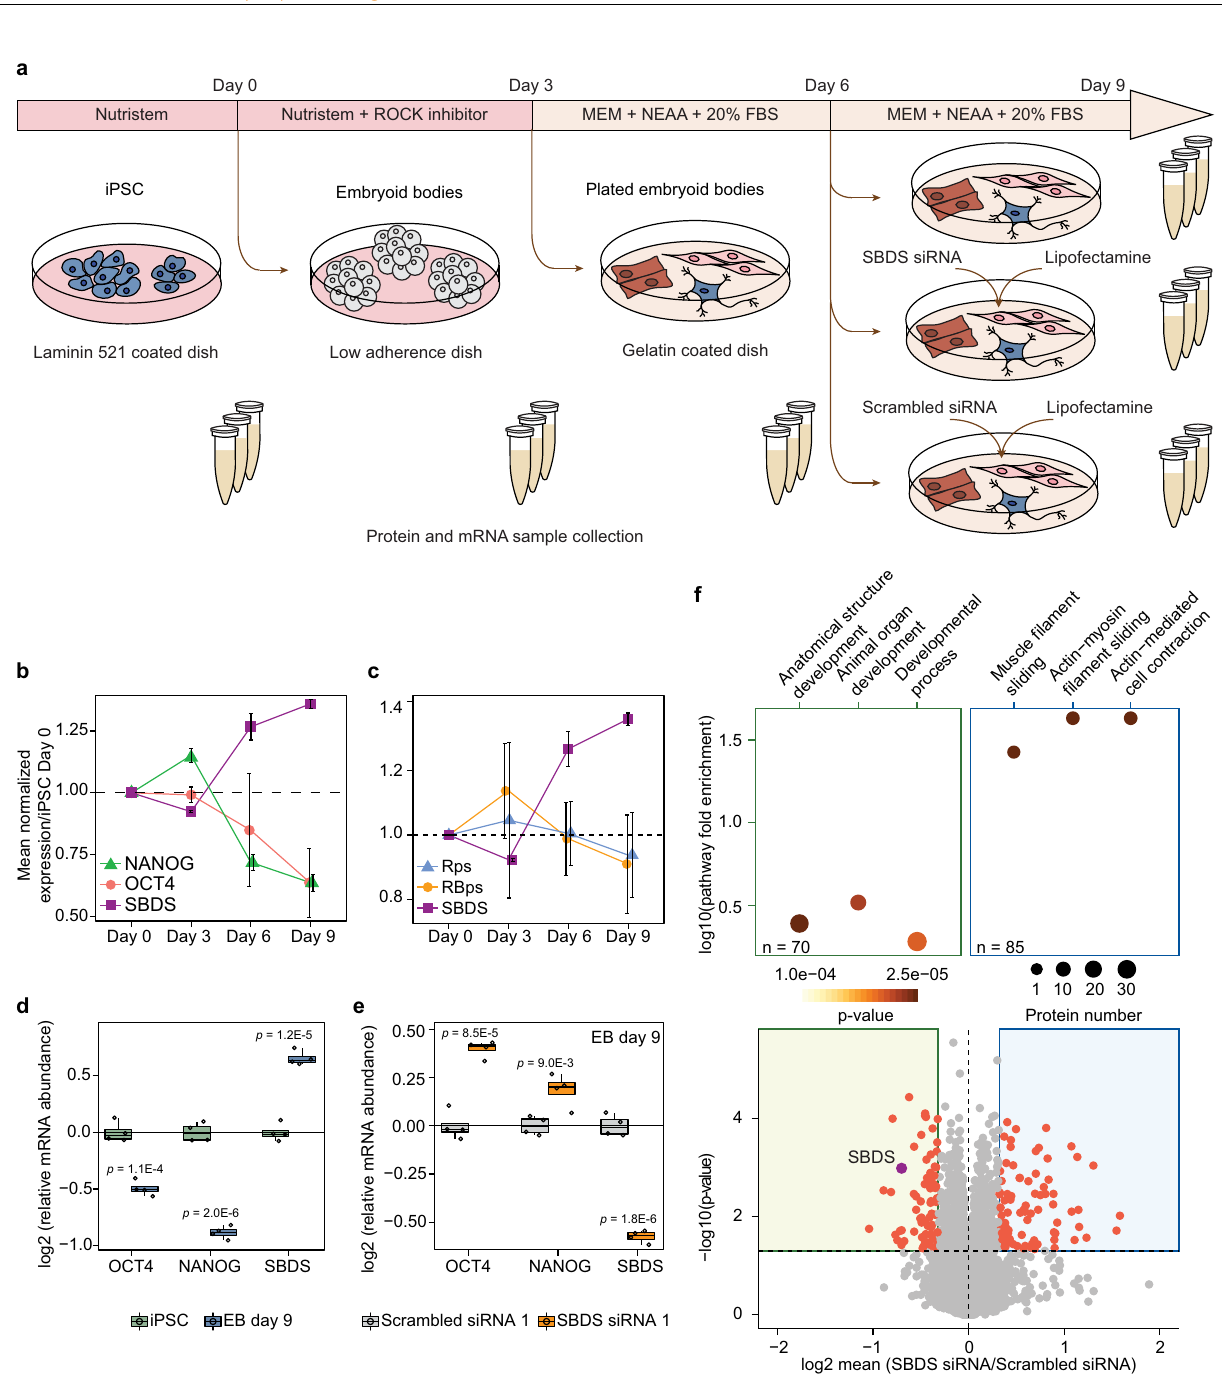
Fig. 6 SBDS protein is involved in differentiation and pluripotency maintenance in PSCs. a Schematic representation of PSCs differentiation into EBs and subsequent SBDS siRNA and scrambled siRNA treatments. b Protein expression of SBDS, OCT4, and NANOG in EBs at different days of their induction normalized to that in hi12 iPSCs at day 0. c Expression of SBDS protein, mean ribosomal proteins expression (Rps) and mean expression of proteins involved in ribosome biogenesis (RBps) encompassing 81 and 237 unique proteins, respectively, in EBs normalized to that in hi12 cells at day 0. Error bars represent ±the standard deviation of the mean. d Relative abundance of SBDS, OCT4, and NANOG mRNAs after nine days (D9) of EBs induction versus that in day 0 (D0) hi12 cells measured using qRT-PCR. e Relative abundance of SBDS, OCT4, and NANOG mRNAs in day 9 EBs after three days of SBDS siRNA and scrambled siRNA treatments. f Relative protein abundance in day 9 EBs after 3 days of SBDS siRNA treatment versus that in the day 9 EBs treated with scrambled siRNA (control); and top three most signi fi cantly up or downregulated pathways according to GO annotation ( P < 0.05 and relative expression <0.8 or >1.25) ( n = 3 biologically independent samples). P -values were calculated using Welsh ’ s t -test for proteomics experiment and using a two-sided Student t -test for qRT-PCR. p < 0.05 were considered as signi fi cant. Horizonal line in the boxplots represent the median, 25th and 75th percentiles and whiskers represent measurements to the 5th and 95th percentiles. n = 3 biologically independent samples for proteomics experiments and n = 4 biologically independent samples for qRT-PCR data. Source data are provided as a Source Data fi